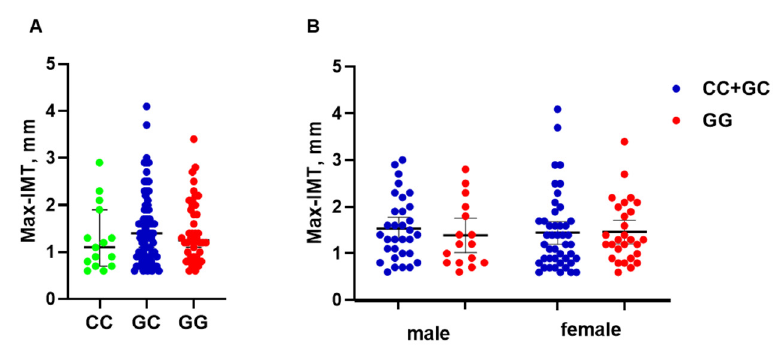
Figure 3. Max-IMT and PNPLA3 genotypes. ( A ) Max-IMT was compared among three PNPLA3 genotypes. ( B ) Comparison of Max-IMT between the two PNPLA3 genotype groups stratified by sex. The middle bar represents the median and the upper/lower bars represent the 95% confidence interval. Max-IMT, maximum intima–media thickness; PNPLA3 , patatin-like phospholipase do- main-containing protein 3.